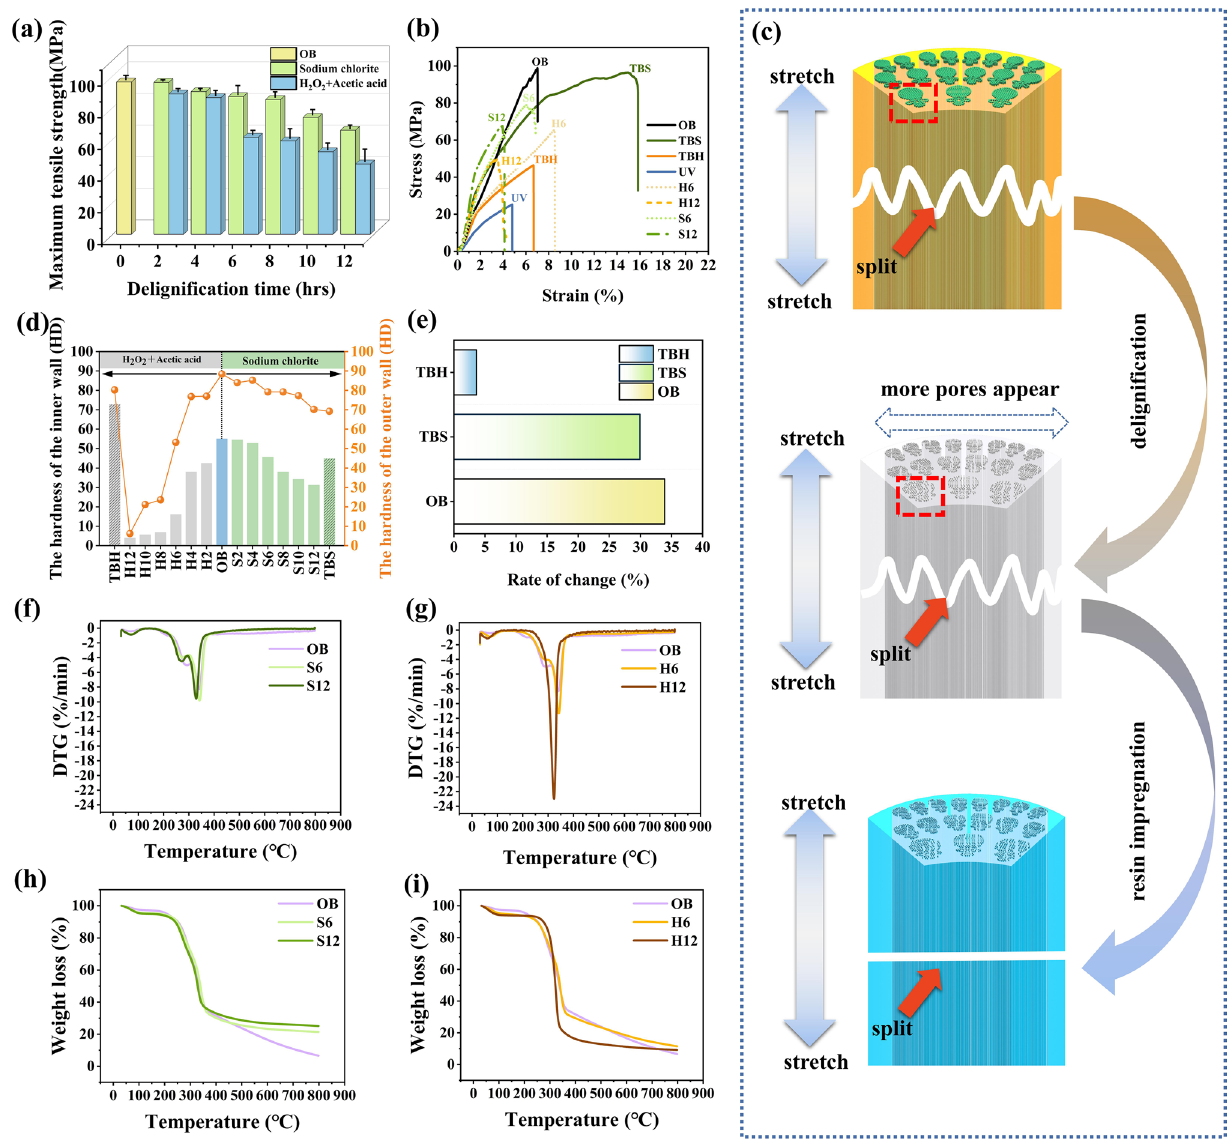
Fig. 5 a Maximum tensile strength of OB and delignified bamboo. b Stress–strain curves of OB, TBS, TBH, UV, H6, H12, S6, and S12. c Schematic diagram of fracture of different samples when being stretched. d Surface hardness of the samples. e Mass change rate after water saturation of OB, TBS, and TBH. f DTG curves of OB, S6, and S12. g DTG curves of OB, H6, and H12. h TG curves of OB, S6, and S12. i TG curves of OB, H6, and